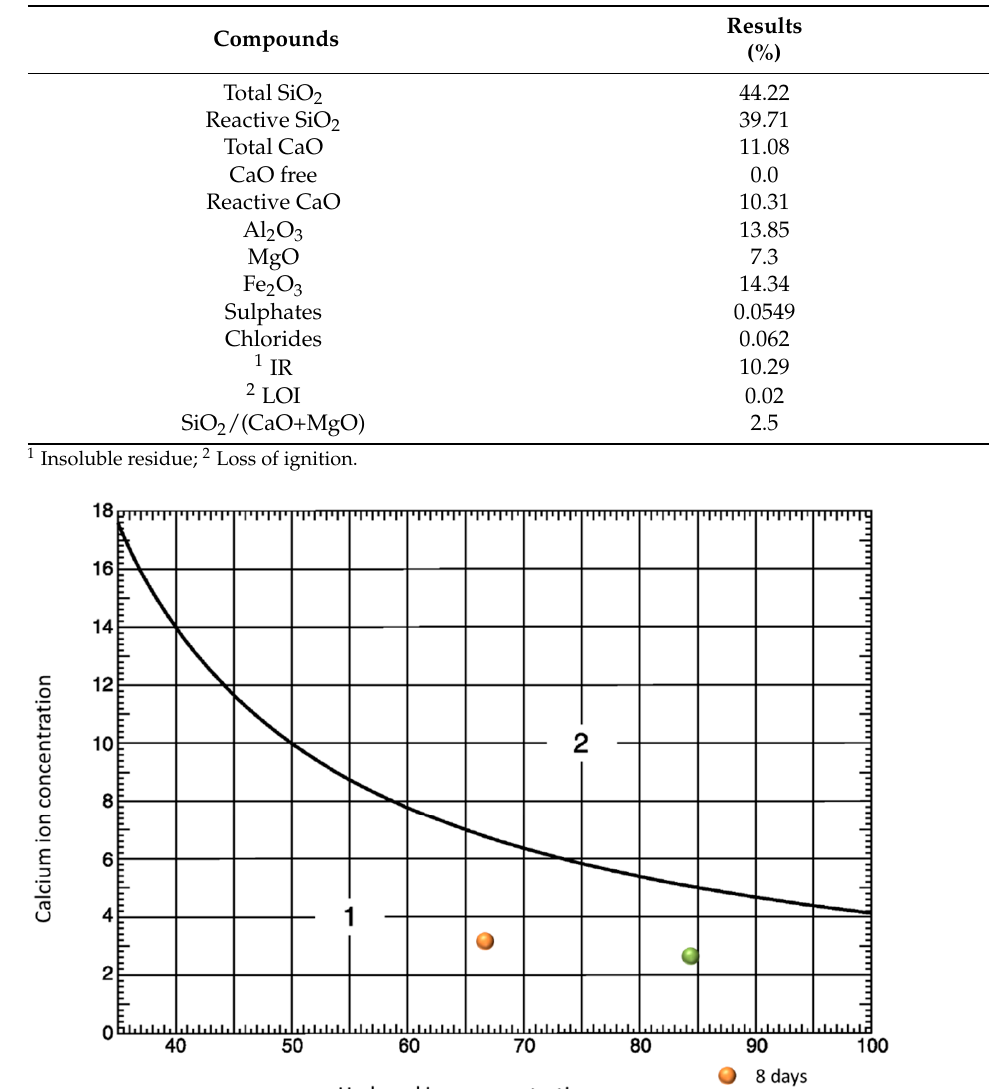
Table 4. Results of the chemical composition and pozzolanic quality of the samples studied.